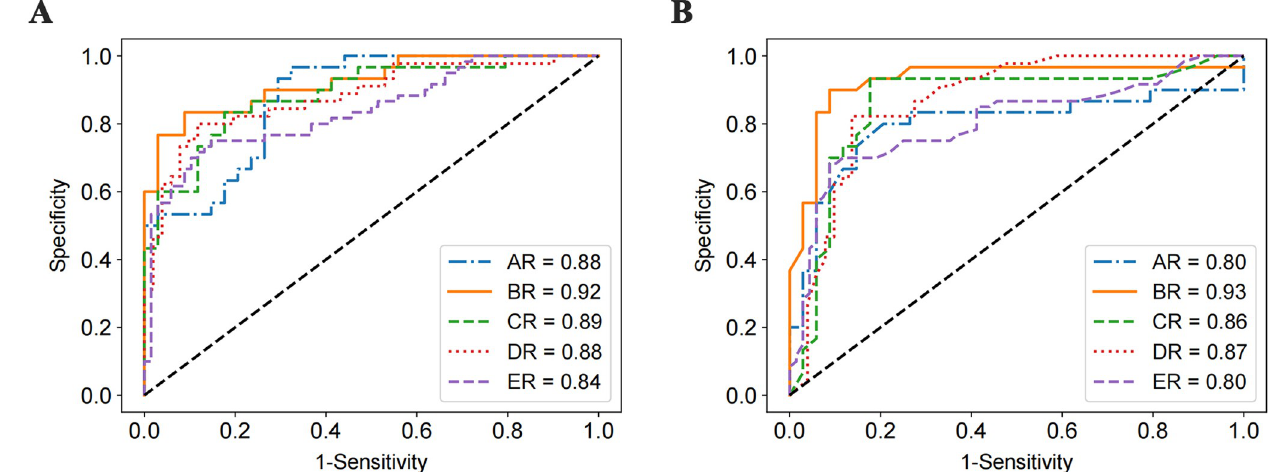
Fig 10. ROC curves comparison of SVM and LSTM results under different augmentation datasets. (A) SVM; (B) LSTM.